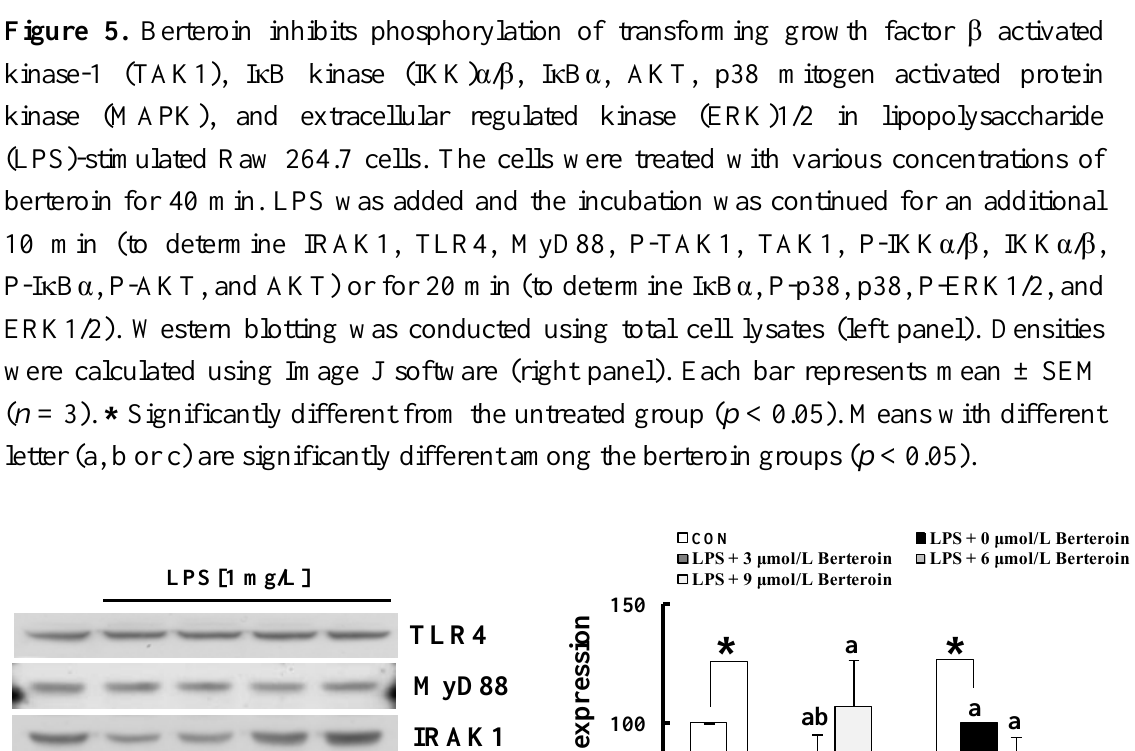
Figure 5. Berteroin inhibits phosphorylation of transforming growth factor β activated kinase-1 (TAK1), IκB kinase (IKK)α/β, IκBα, AKT, p38 mitogen activated protein kinase (MAPK), and extracellular regulated kinase (ERK)1/2 in